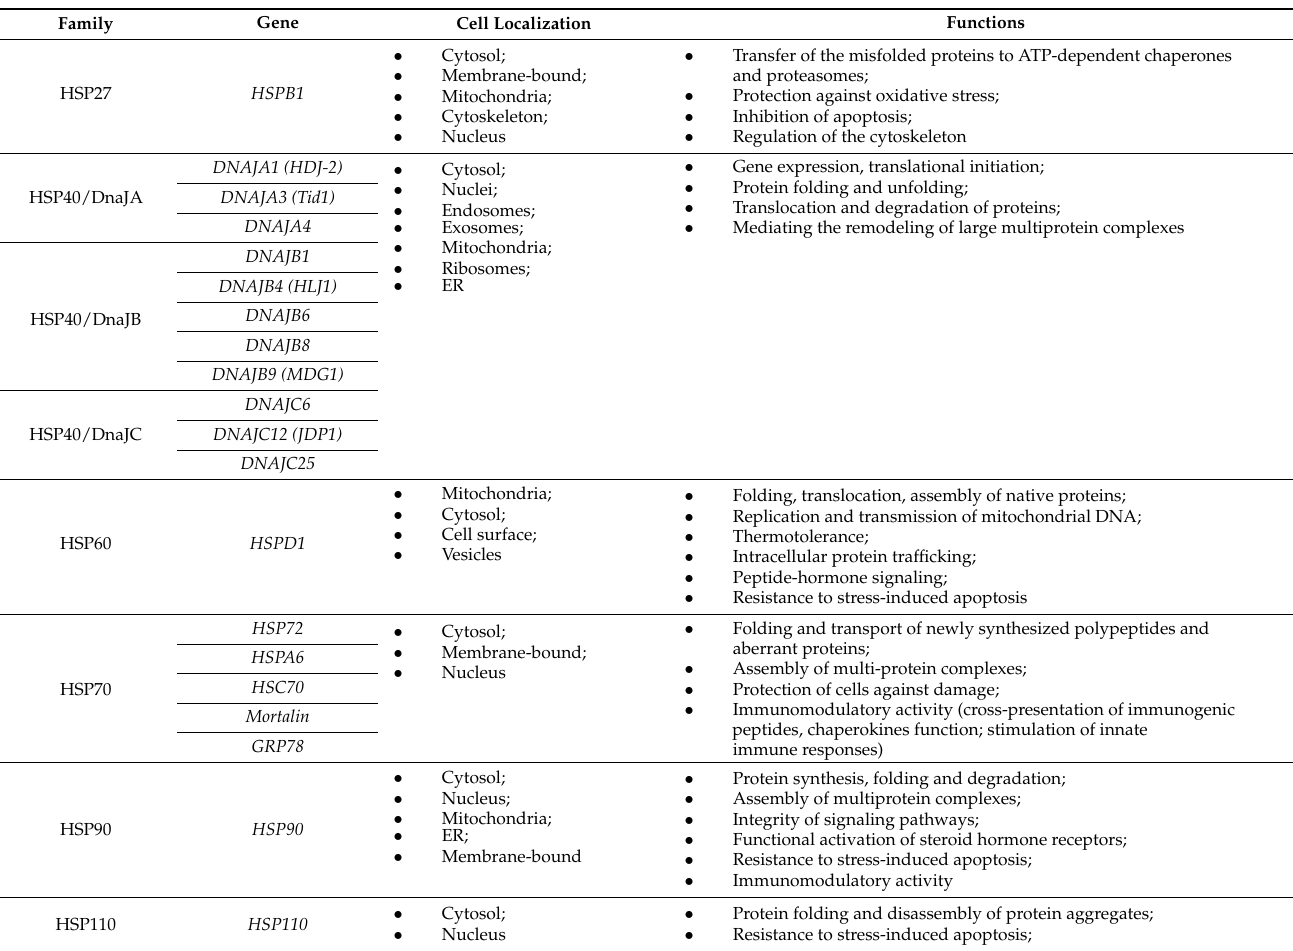
Table 1. Roles of major HSP family members in cell